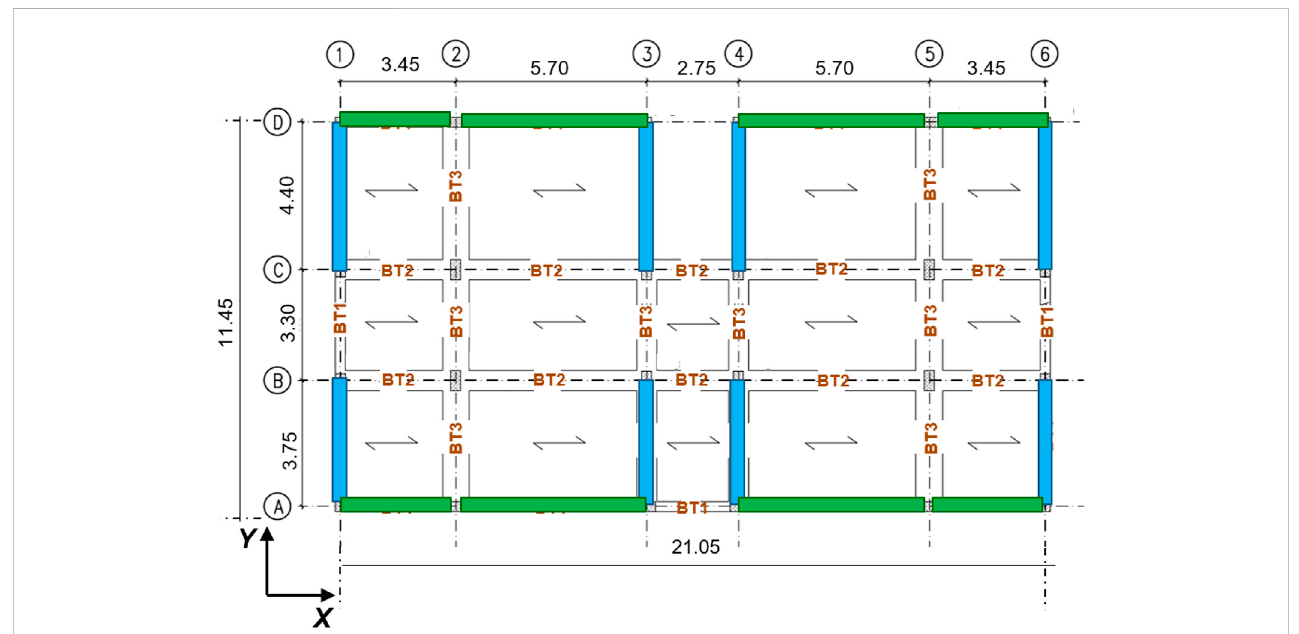
FIGURE 7 Positions of the dissipative bracing system in plan (green and light blue rectangles).